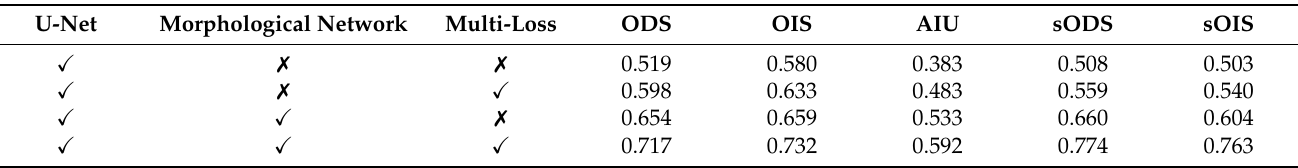
Table 7. Ablation experiment